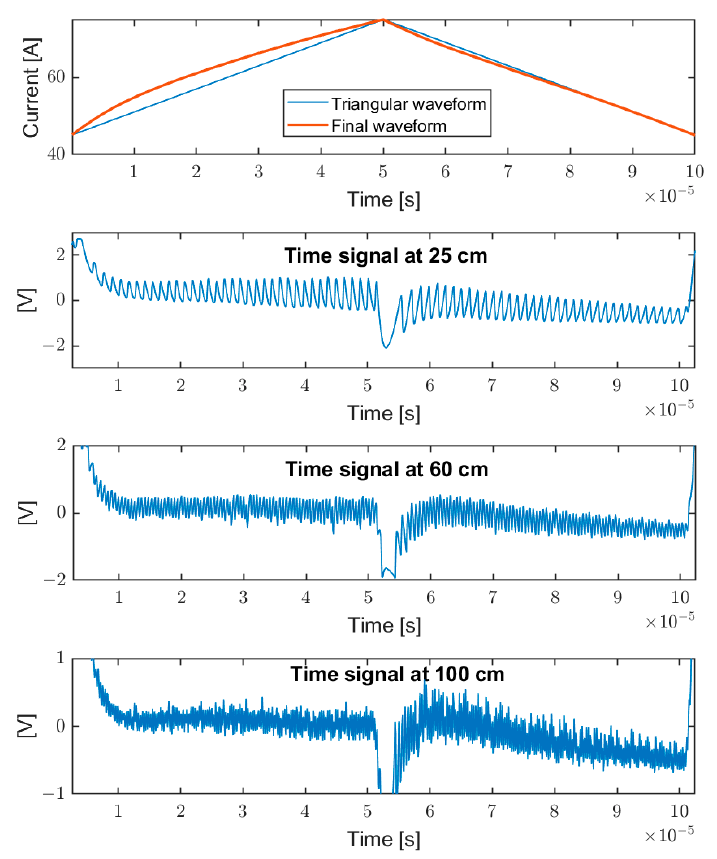
Figure 6. Upper pane: laser diode modulation, triangular (thin line), and pre-distorted wave (thick line). Lower panes: corresponding self-mixing signals, for different target distance (25 cm, 60 cm, and 100